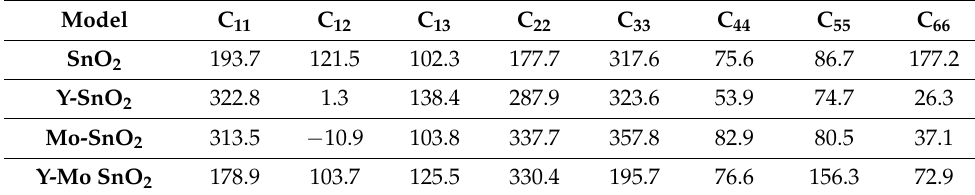
Table 5. Elastic coefficients of each